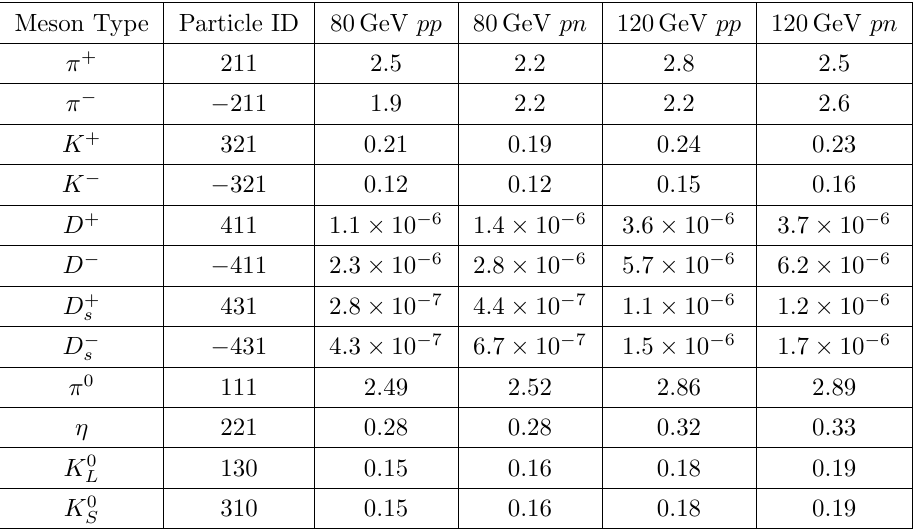
Table 6 . Average number of mesons produced per proton-on-target assuming 80 or 120 GeV protons striking protons or neutrons. See text for more